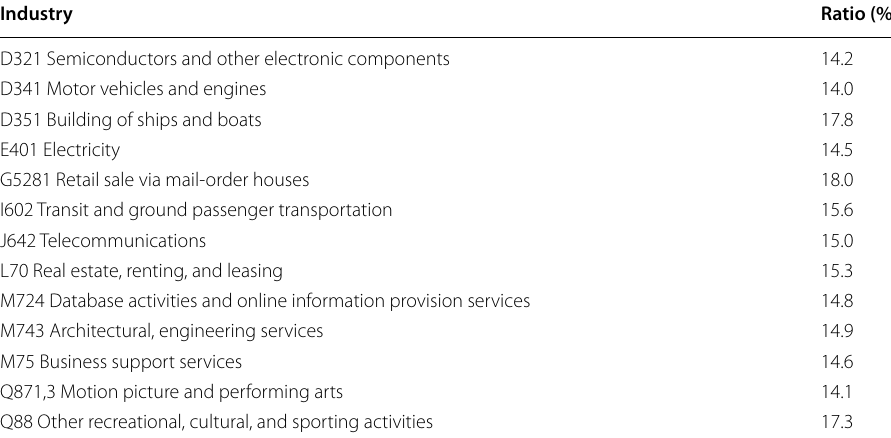
Table 10 Industries highly dependent on foreign